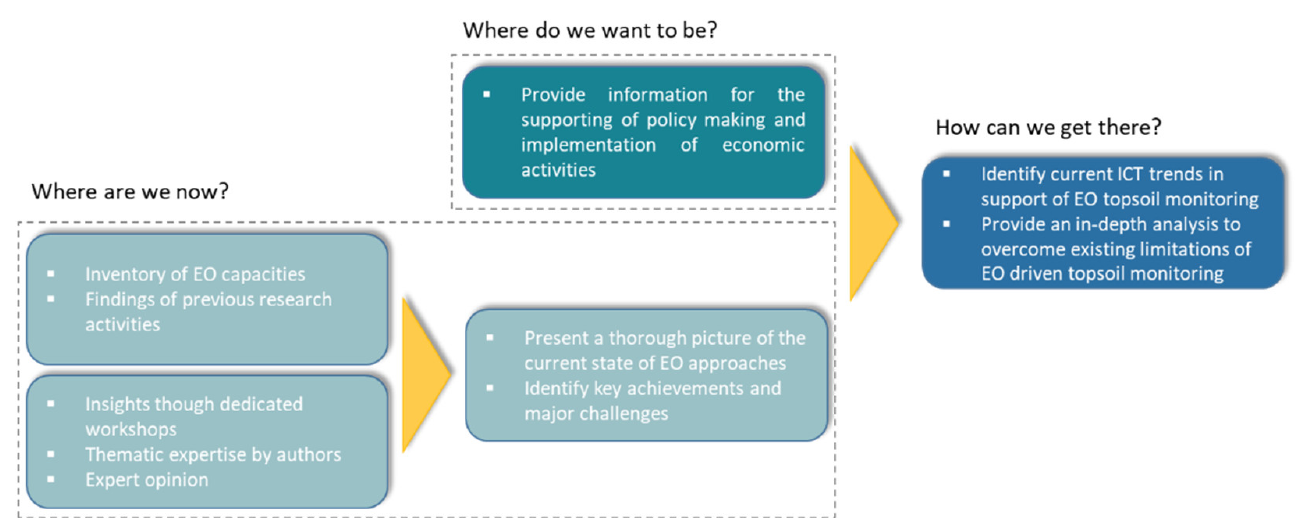
Figure 1. The methodological framework to answer the main key questions regarding the review of various components of EO data-driven soil monitoring.